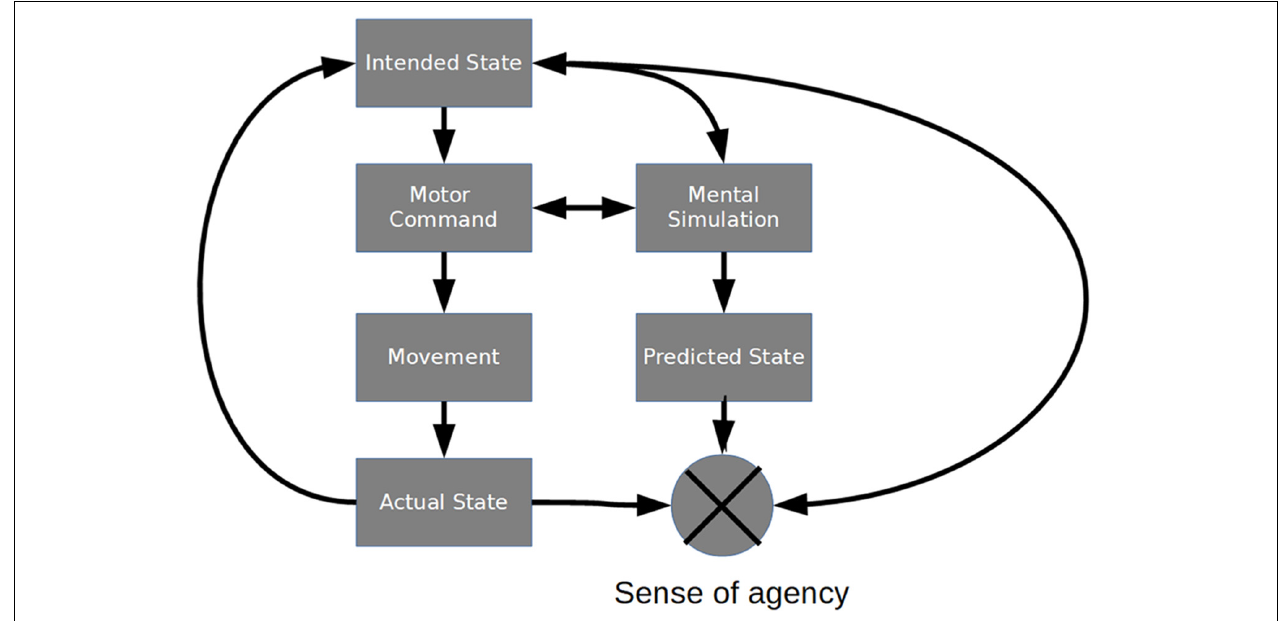
FIGURE 1 | Comparator model of the sense of agency. Control involves a coupling of perceptual, motor, cognitive, and metacognitive processes. Motor actions are made in response to monitoring differences between the actual state of the system and intended (or future) goal states. A sense of agency arises from comparing the intended, predicted, and actual states of the system as motor commands are carried out. Awareness of discrepancies leads to detection of loss of